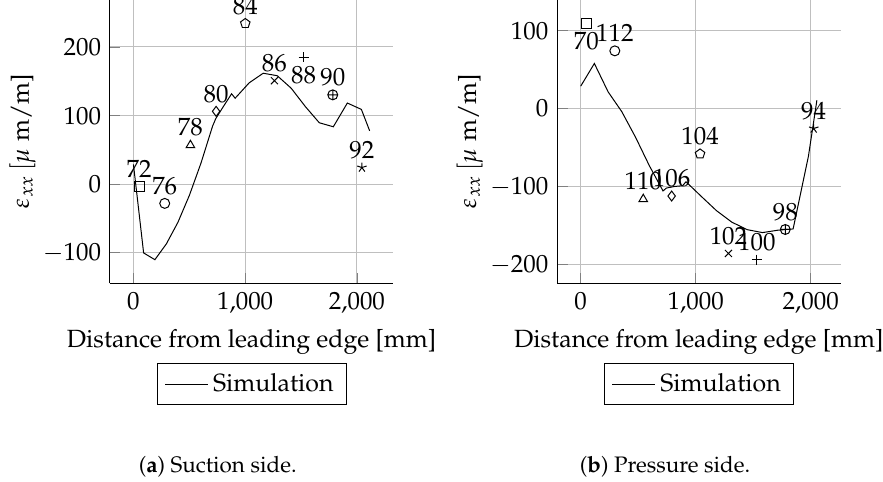
Figure A56. Strain comparison ε LL at radial position R = 8000mm for torsion load case